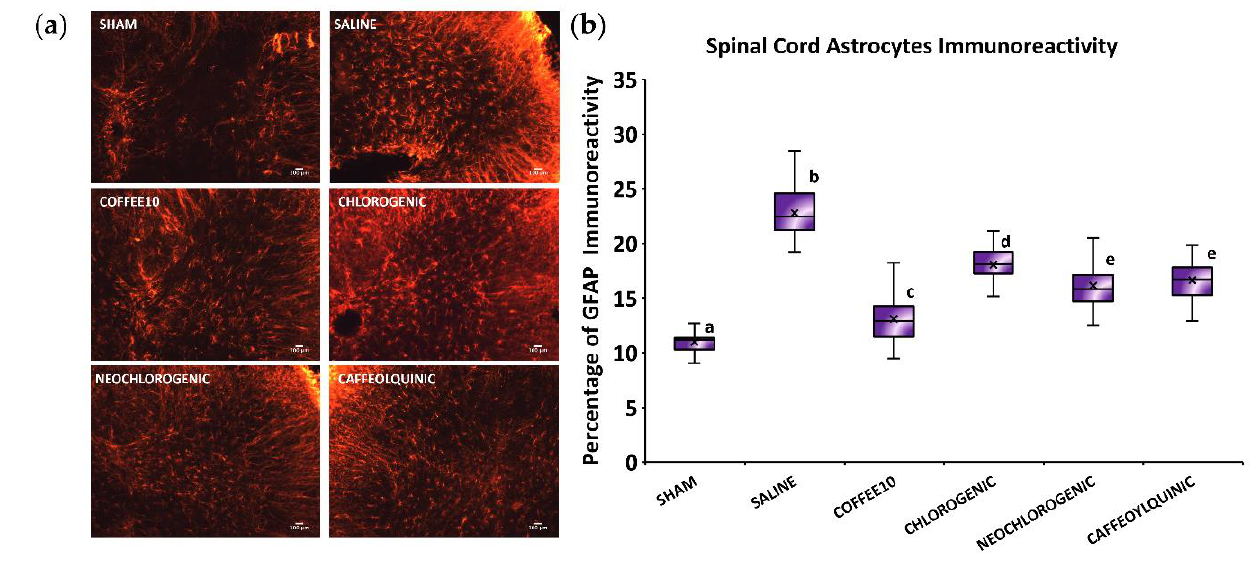
Figure 3. Spinal cord astroglia after polyphenolic treatments fourteen days post-injury: ( a ) Repre- sentative GFAP images of dorsal horn for each group. Scale bars = 100 µ m; ( b ) Percentage of GFAP immunoreactivity. Data are illustrated as median ± IQR, and the x indicate the mean. a–d: not sharing a letter means significant differences, p < 0.05.